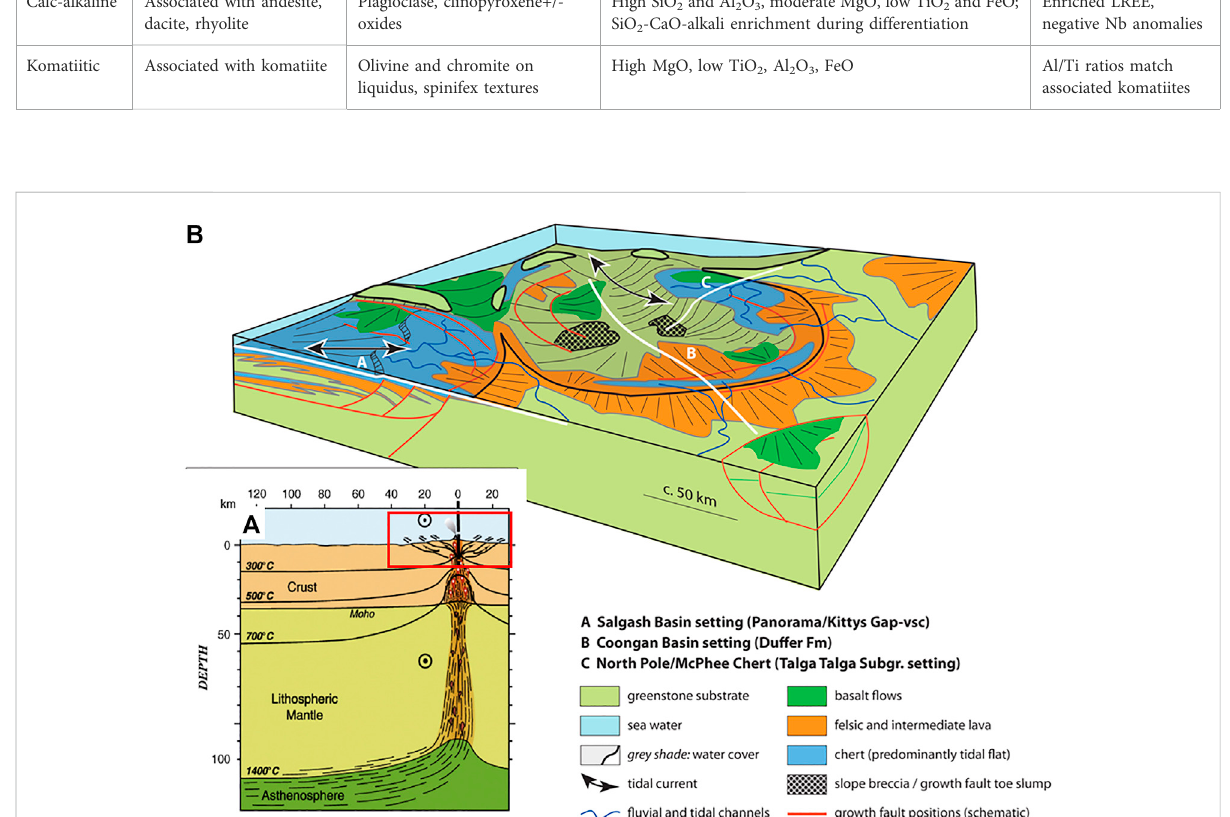
FIGURE 3 Schematic illustration of tectonic fracturing and basin formation on the early Earth. (A) A cross section of the early Earth ’ s crust and mantle highlightingcrustalfracturingaroundtheintersectionbetweenthemantleplumeandthetopofthecrust(outlinedbyaredbox)(afterVauchezetal., 2012). (B) Block diagram model of the upper crust, equivalent to the red box in (A) , showing the formation of collapse basins bordered by faults and fracturesinthesoftercrustoftheHadeanandPalaeoarchaeanresultingintheformationofshallowwaterbasinsontopoftheoceanicplateaux/ protocontinents (after Nijman et al.,